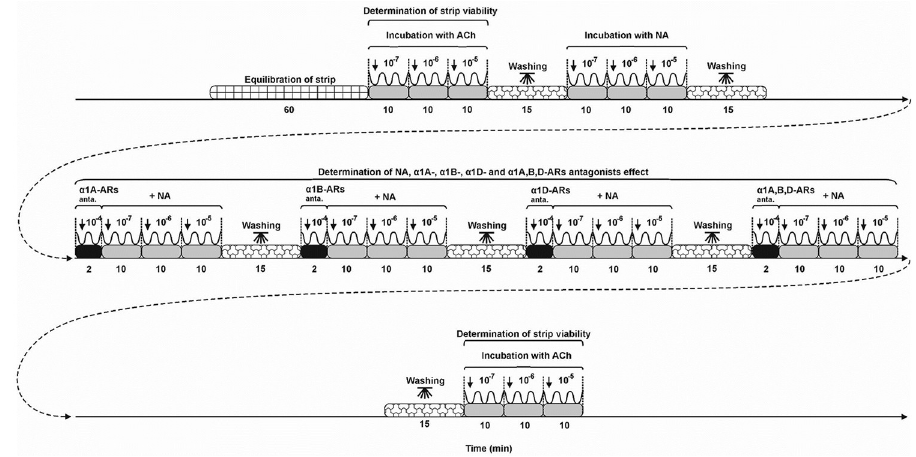
Fig 1. Diagram showing treatment of uterine strips. ACh–acetylcholine; NA—noradrenaline; α 1A-ARs anta.– antagonist of isoform A of adrenoreceptor subtype α 1; α 1B-ARs anta.–antagonist of isoform B of adrenoreceptor subtype α 1; α 1D-ARs anta.—antagonist of isoform D of adrenoreceptor subtype α 1; α 1A,B,D-ARs anta.–antagonist of isoforms A,B,D of adrenoreceptor subtype α 1. Substance concentrations are given in moles.